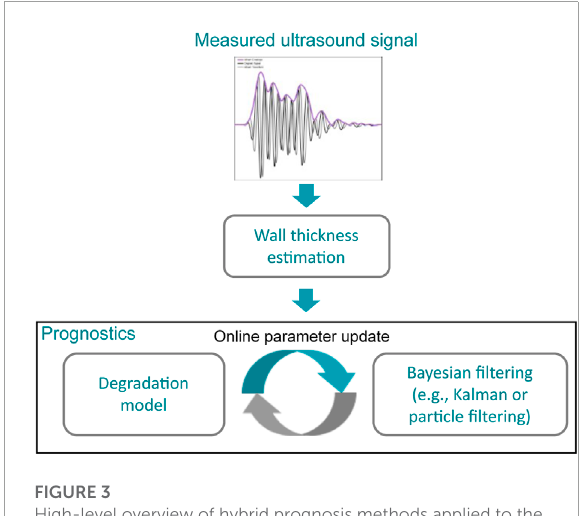
FIGURE 3 High-level overview of hybrid prognosis methods applied to the problem of corrosion prognosis using